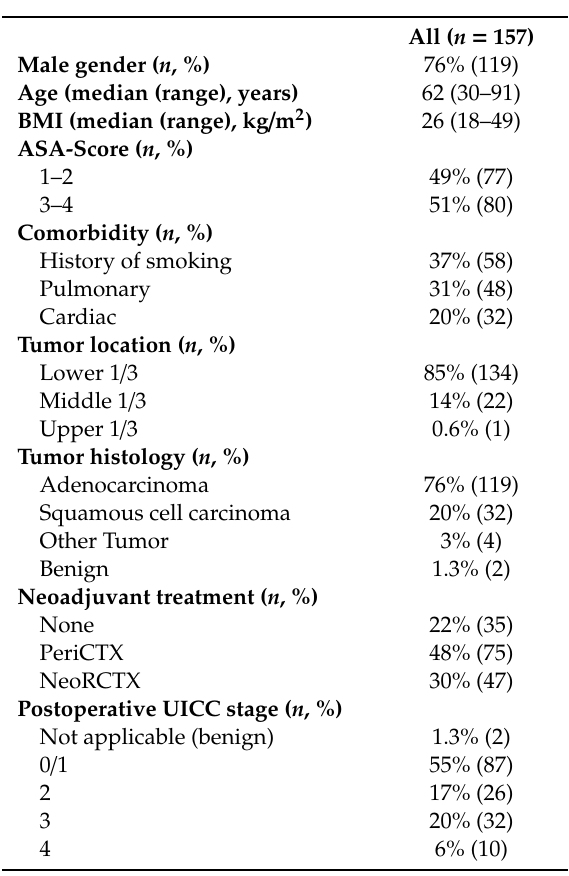
Table 1. Clinicopathological